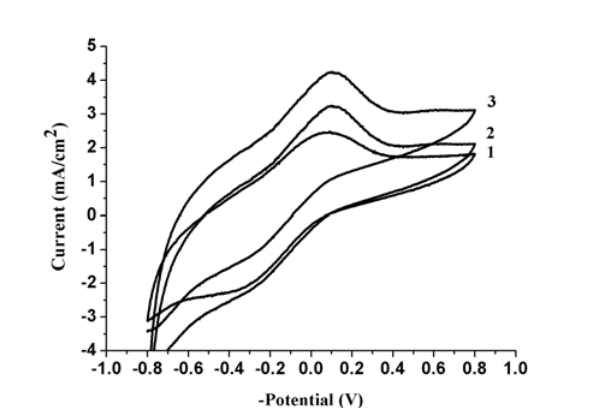
Figure 2. Cyclic voltammetric curves of PPy nanowire modified electrode with a scan rate at 5 mVs -1 in 0.5 M H SO solution containing: (1) no NO 3- ; (B) 2.2 mM NO 3- ; (C) 3.6 mM NO 3- 2 4